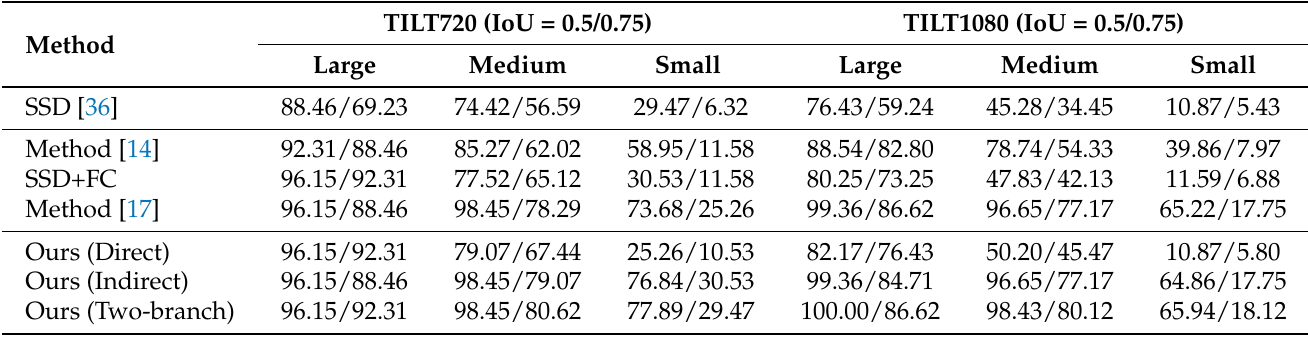
Figure 8. ( a ) The height of the horizontal bounding box H Hbbox . ( b ) The distance between the top-left corner and the straight line formed by the bottom-left and bottom-right corners H Qbbox . In this work, the height of the license plate is defined as H Qbbox . The license plate is manually covered with a yellow ellipsoid to protect privacy. Table 4. Comparative experiments of the multiscale license plate. The values represent the Recall based on the quadrilateral bounding